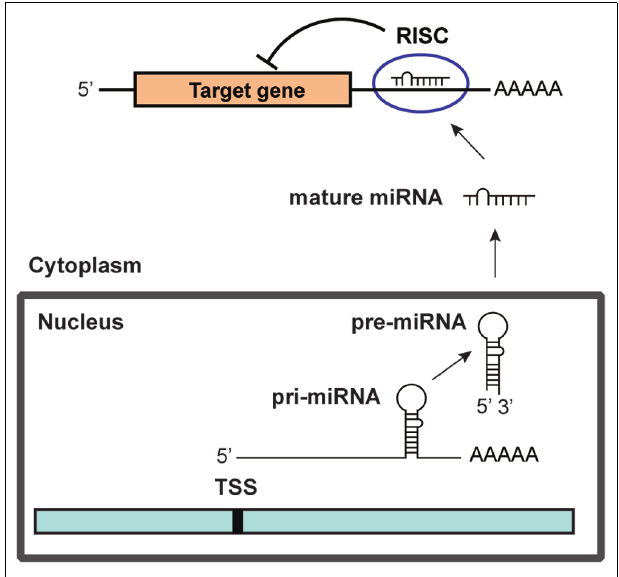
FIGURE 1 |The biogenesis of